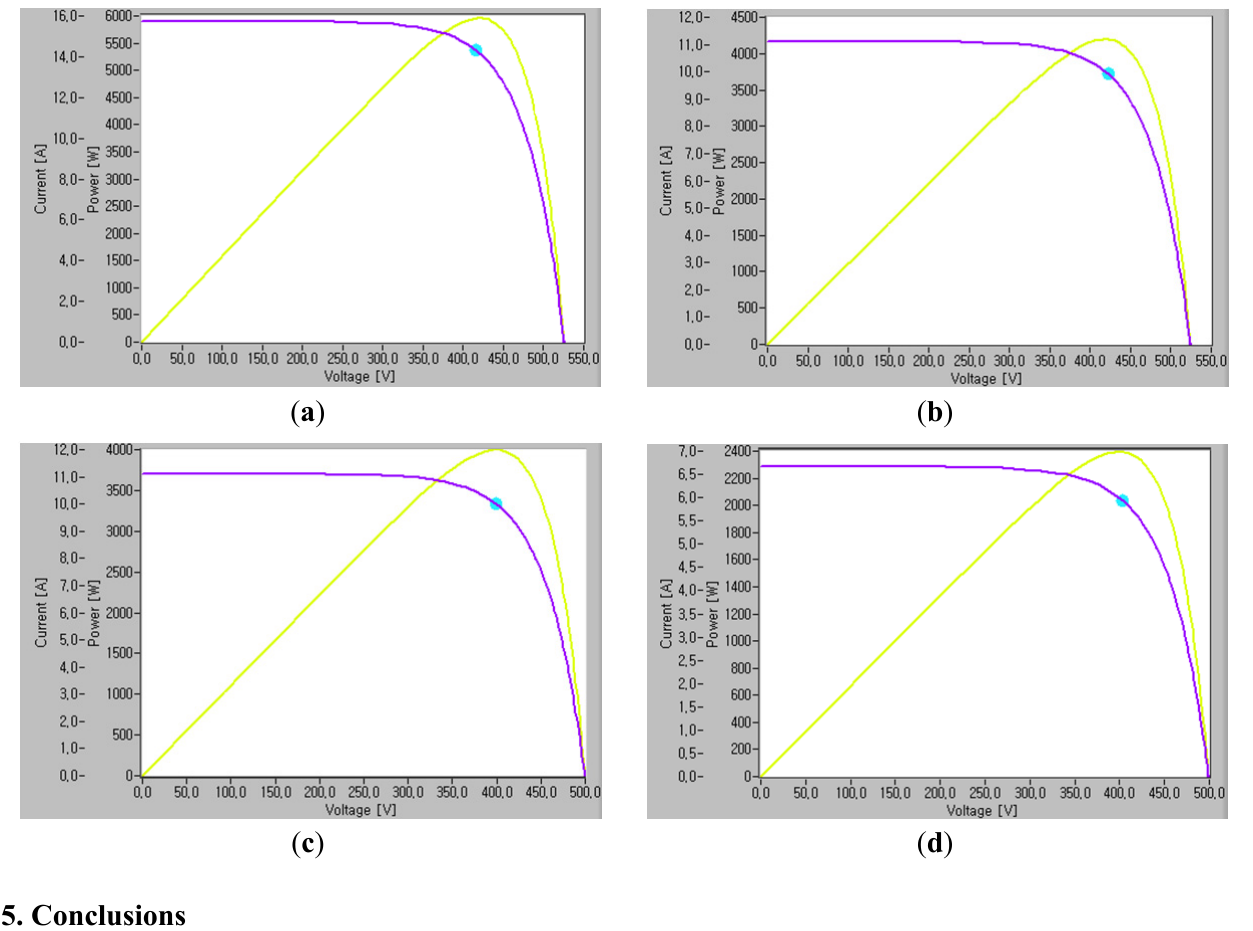
Figure 24. PV-curves of PV1 and PV2 according to radiation. ( a ) PV-curve of PV1 at radiation of 100%; ( b ) PV-curve of PV1 at radiation of 70%; ( c ) PV-curve of PV2 at radiation of 100%; ( d ) PV-curve of PV2 at radiation of